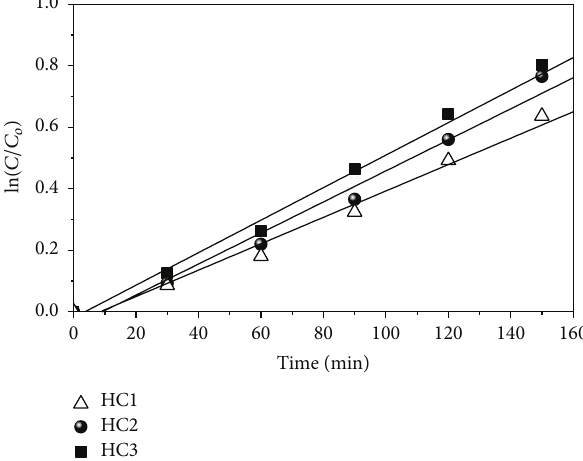
Figure 9: Reaction kinetics of 2, 4-D